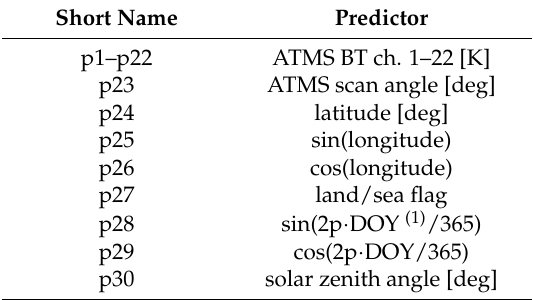
Table 3. Predictors definition for the RF training